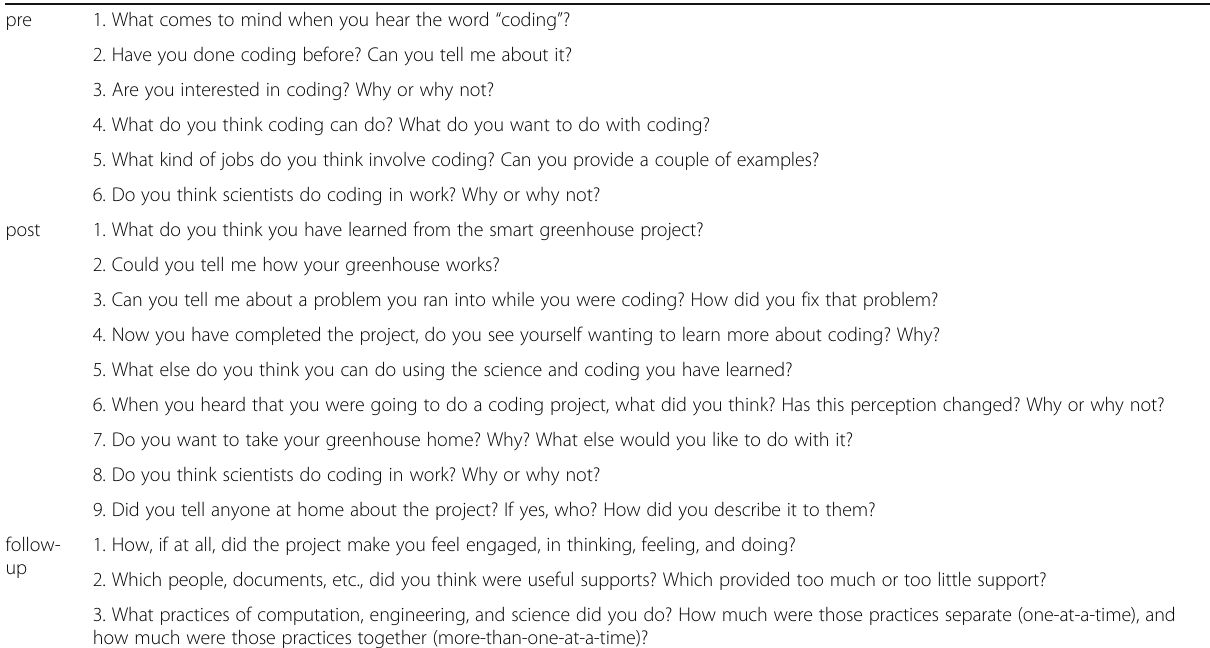
Table 4 List of interview questions